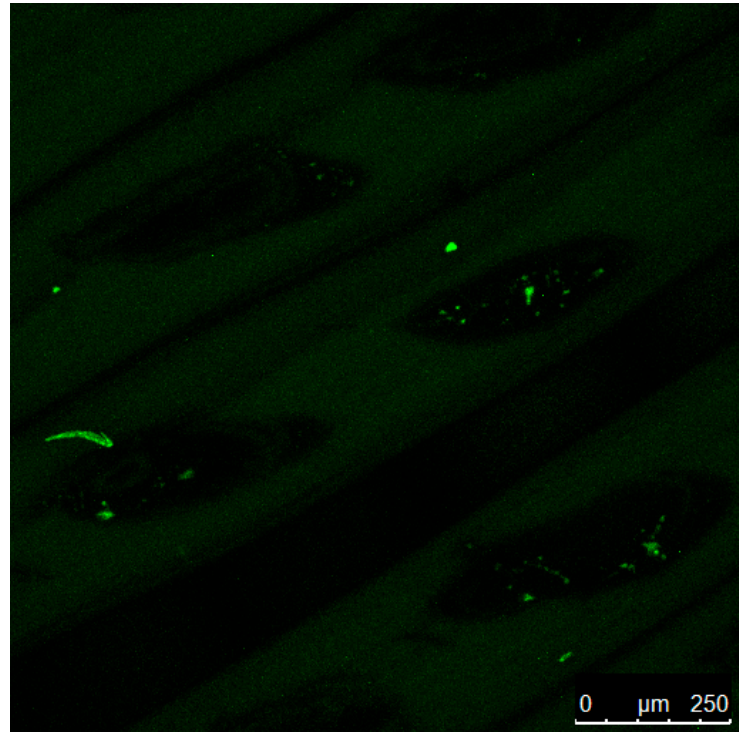
Figure 4. Laser confocal image of top surface of a printed PLA Sample.